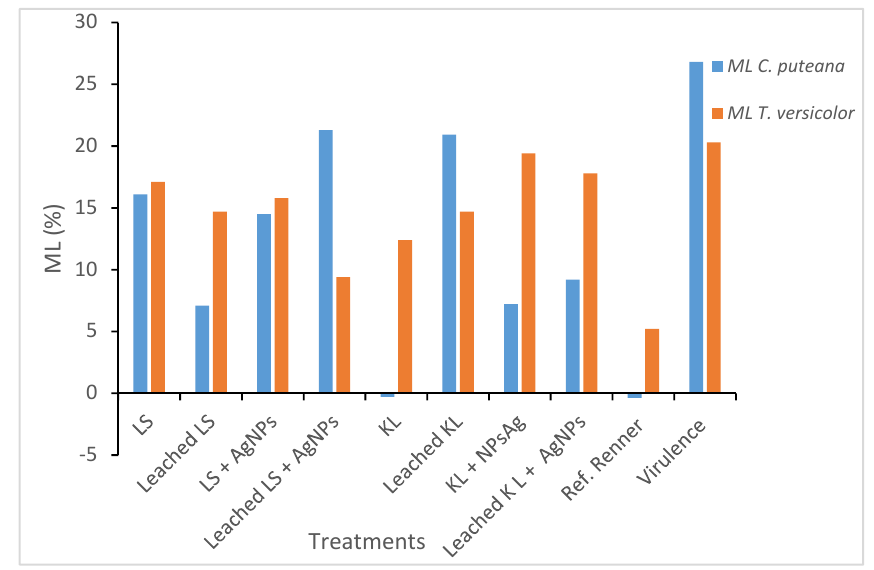
Figure 3. Mass loss (%) after exposition of treated wood to C. puteana and T. versicolor . In the histogram graph, the mass loss percentages of the different treatments and of the respective virulence wood blocks are reported. The controls, performed one by one for each treatment, are not reported in the